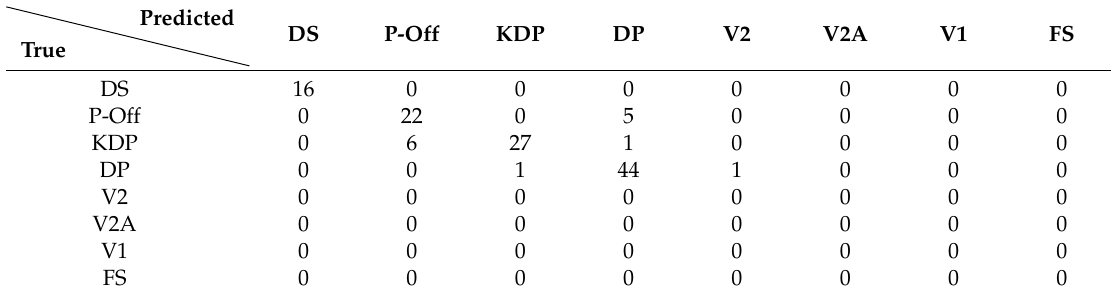
Table 13. Confusion matrix for the flat course, classical style validation set of skier 3 when using the sports biomechanics configuration of sensors.